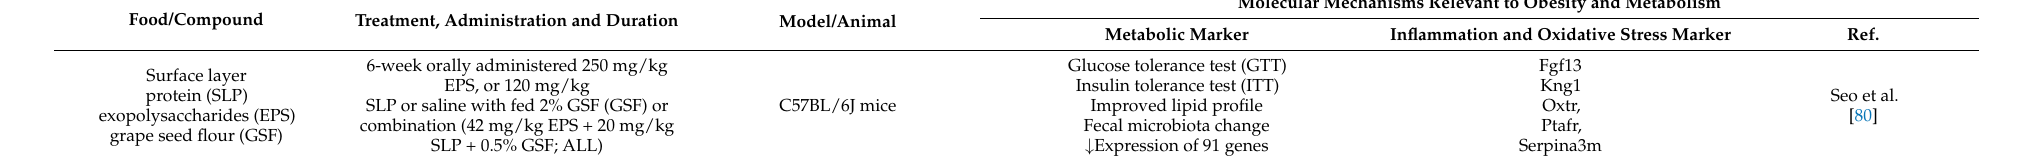
Abbreviations in Table 1 in alphabetic order: ABCG = ATP Binding Cassette Subfamily G, ACC = acetyl CoA carboxylase, ACS = acyl-CoA synthetase, ACSL-1 = Acyl-CoA synthetase long-chain family member 1, Akt2 = protein kinase B β , ALT = Alanine transaminase, AMPK- α = Adenosine 50-monophosphate-activated protein kinase- α , ANGPT-L3 = Angiopoietin- like 3, AOX = Alternative oxidase, AST = Aspartate transaminase, AT = adipose tissue, ATGL = Adipose triglyceride lipase, BW = body weight, CAT = Catalase, CCK = cholecystokinin, CD = cluster of differentiation, C/EBP = CCAAT-enhancer-binding proteins, CFU = Colony Forming Unit, COX-2 = Cyclo-oxygenase 2, CPT-1 = carnitine palmitoyl